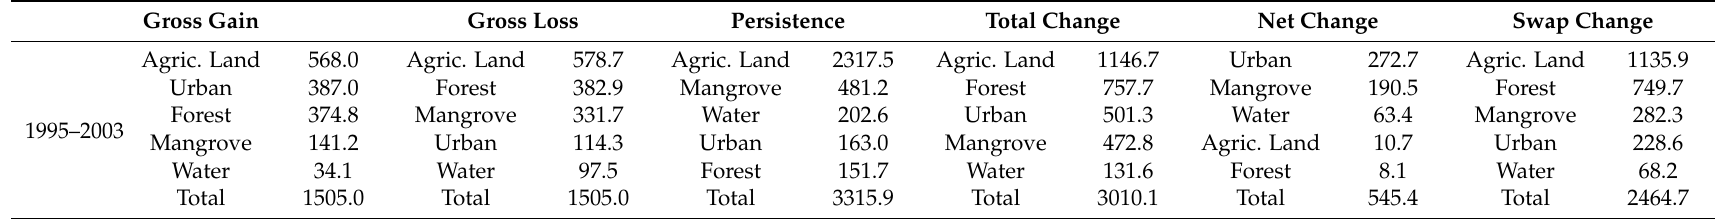
Table 10. Ranking of gross gains, gross losses, persistence, total change, and swap change of LULC categories between 1995–2003. Gross